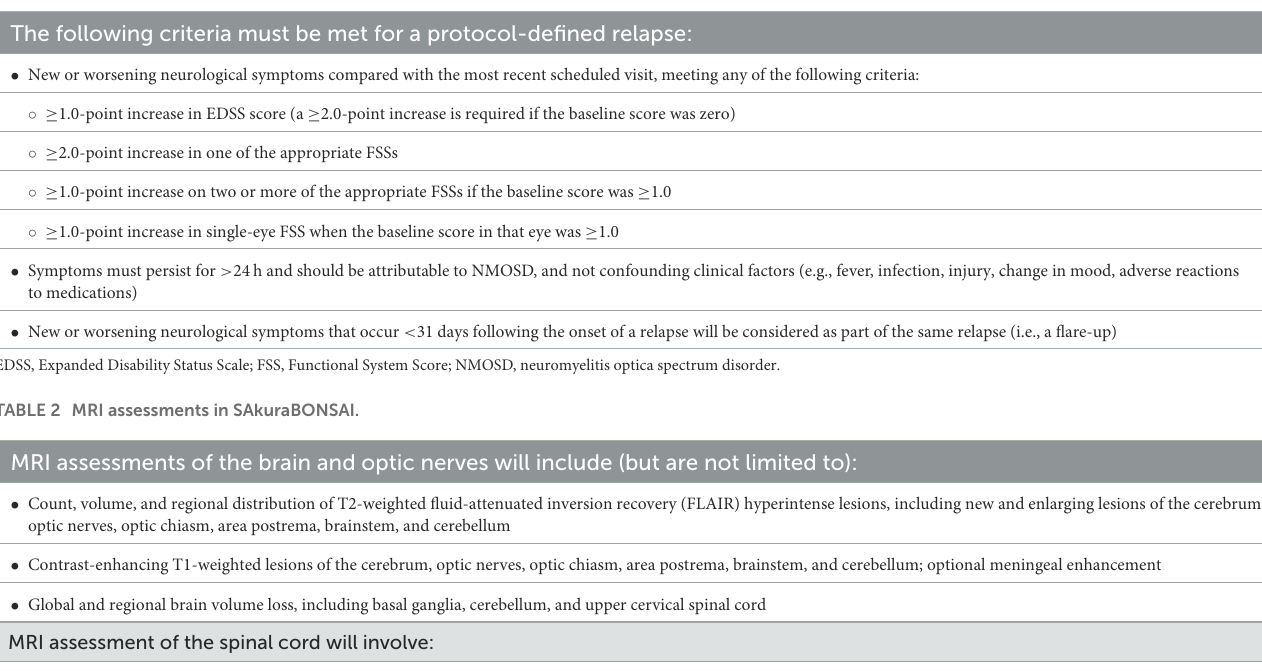
TABLE 1 Protocol-defined relapse criteria.